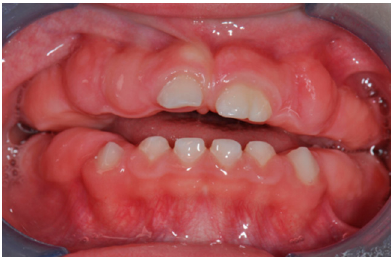
Figure 2. Pre-treatment intraoral photo.